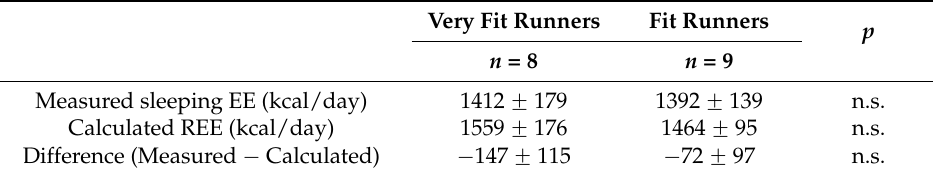
Table 3. Measured sleeping energy expenditure and calculated resting energy expenditure.